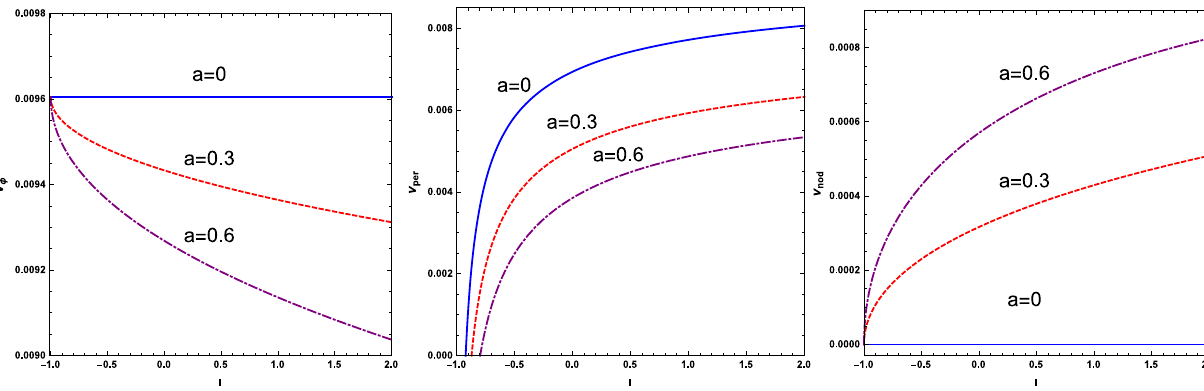
∂ 2 V eff ∂ 2 V eff | θ = π | θ = π , − , and the coefficients 1 ∂ r 2 ∂θ 2 2 2